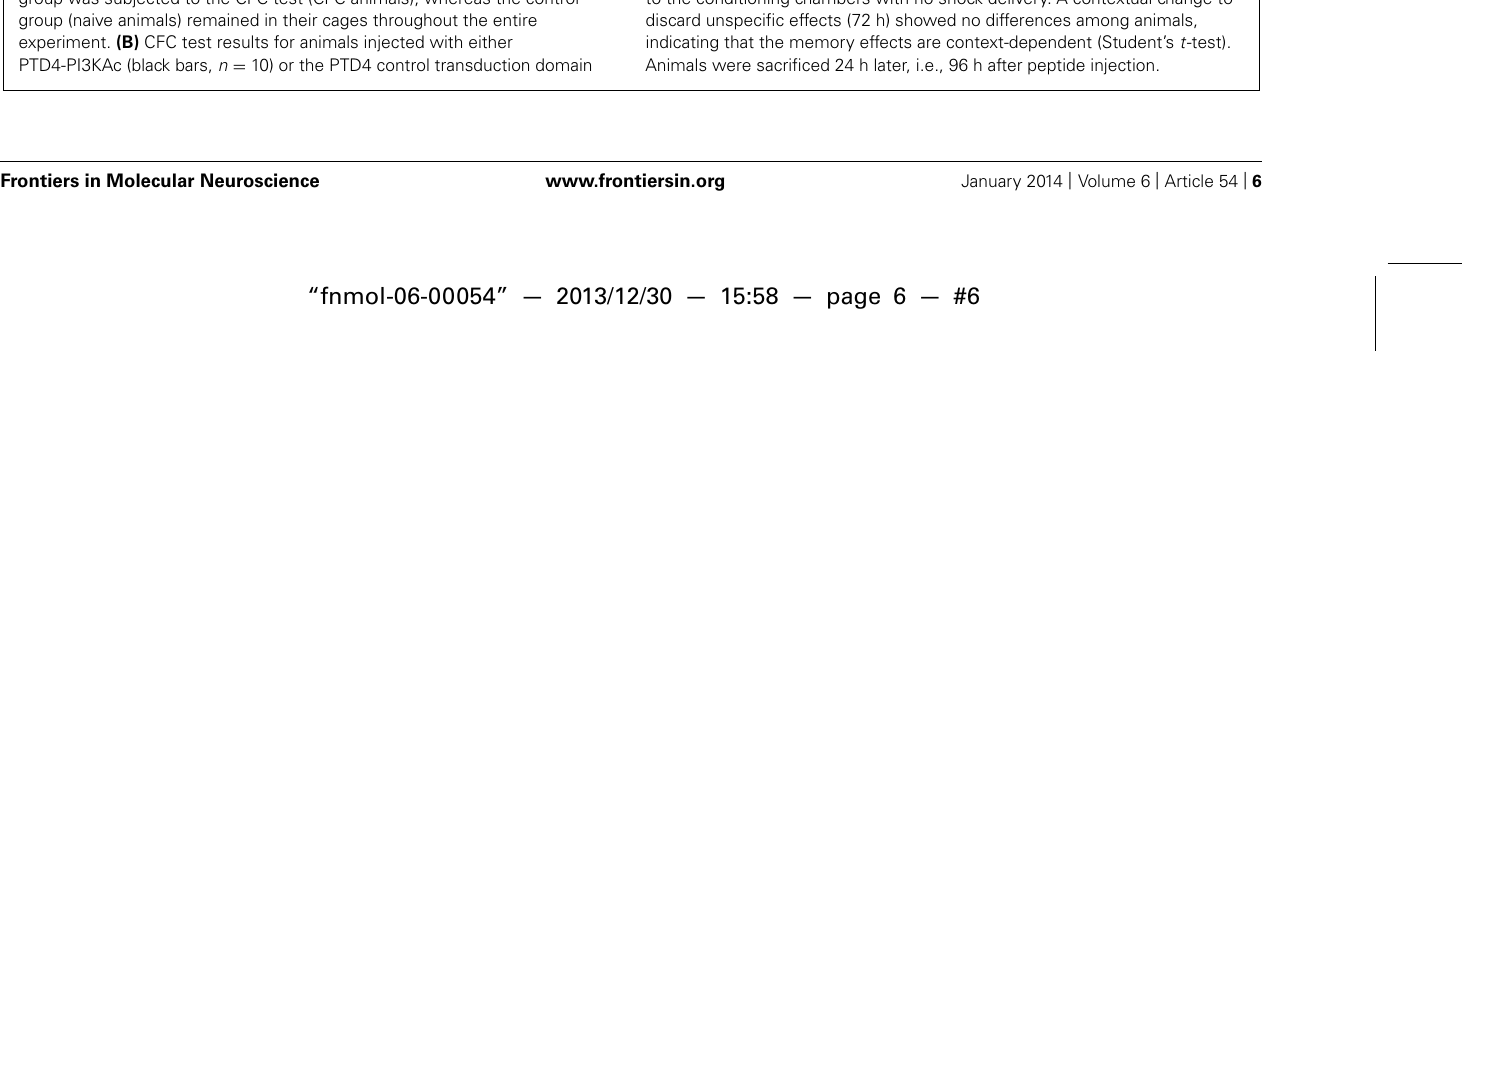
(open bars, n = 10). No differences in freezing were observed during conditioning (24 h), indicating normal fear acquisition and no differences